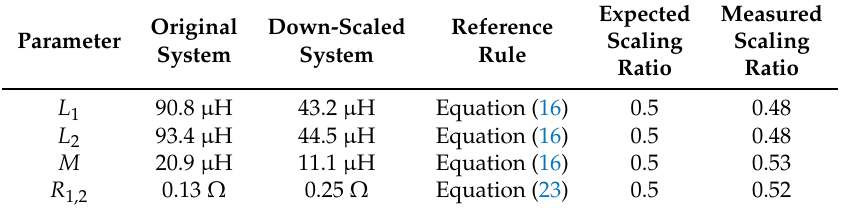
Expected Measured Scaling